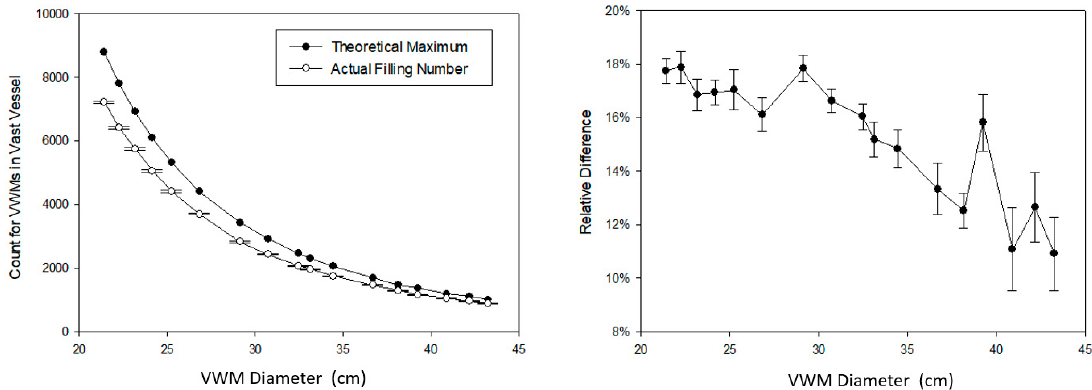
Figure 9. The actual filling experiment of VWMs using different diameters from 21.416 to 43.245 cm in a vast vessel. ( Left ): The quantity difference between the theoretical and the actual with standard deviation; ( Right ): The relative difference between the theoretical and the actual with relative standard deviation.